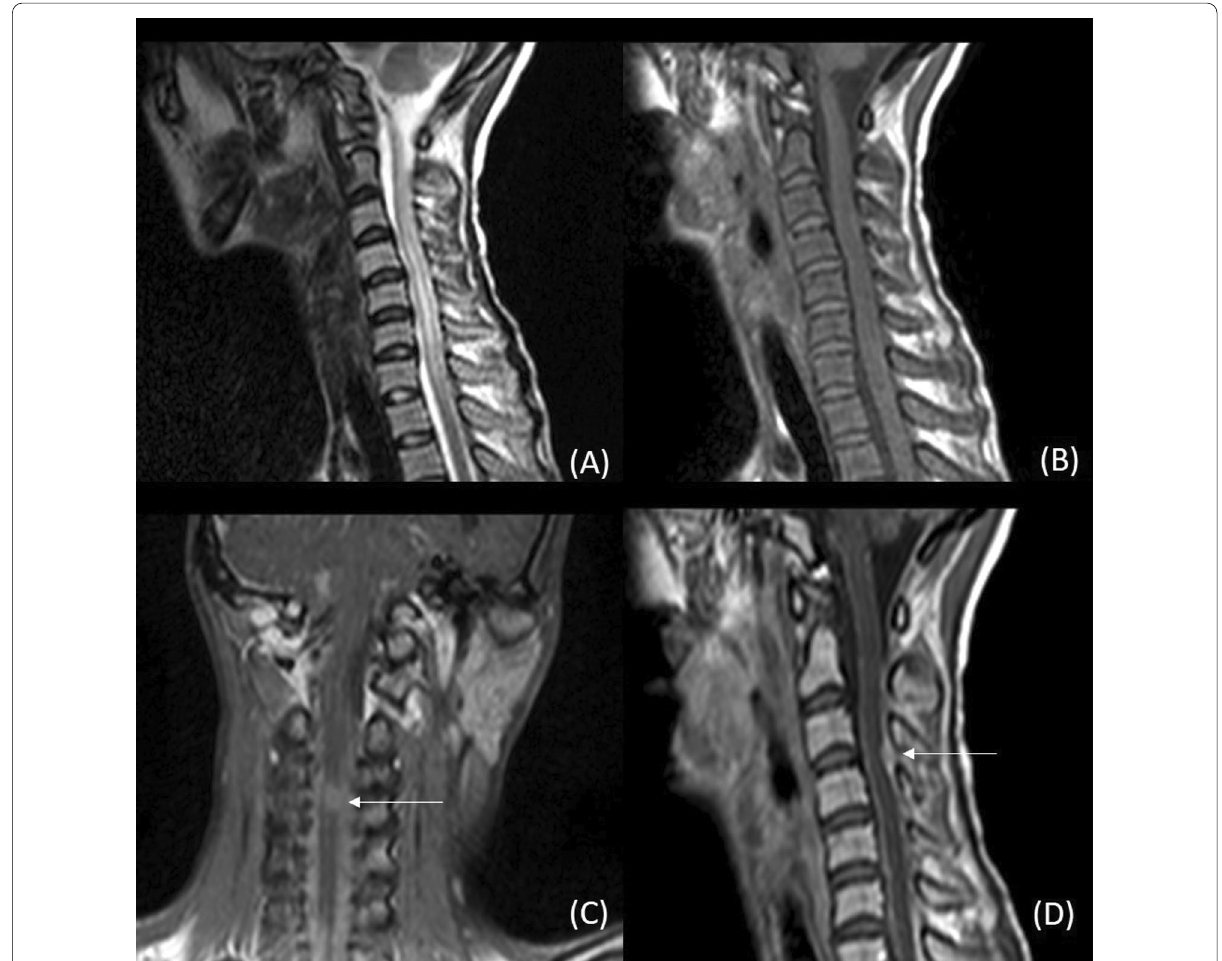
Fig. 5 Extramedullary intradural tubercular granuloma with cord oedema. MRI of a 32-year-old female shows cord expansion with high signal intensity in the cord from C3 to C7 vertebral levels, suggestive of cord oedema on sagittal T2W image ( A ), T1W image also shows cord expansion at the same level ( B ), T1 contrast-enhanced images show a well-defined peripherally enhancing extramedullary intradural lesion posteriorly at C3–C4 vertebral level (white arrow in C and D